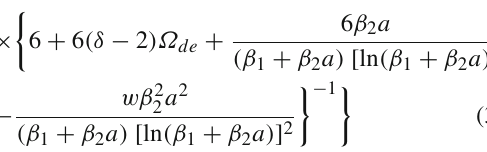
Fig. 6 Plot of density parameter of interacting THDE model versus redshift z for β 1 = 7 . 1, β 2 = 2 . 15, w = 1000, Ω 0 δ = 1 .